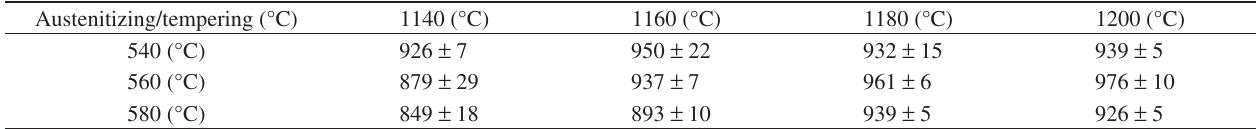
Table 2. Vickers hardness results for the twelve hardening conditions. Austenitizing/tempering (°C)